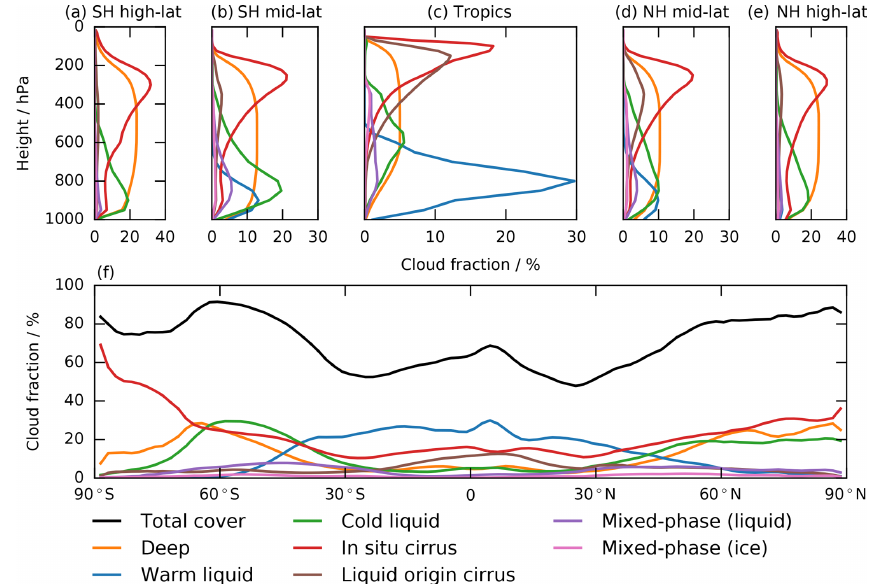
Figure 12. Same as in Fig. 5 but for the absolute frequency of occurrence profile (a–e) and relative contribution to the total cloud cover (f) . The relative contribution is computed as the fraction of cloud volume occupied per column and cloud type. Data are sampled every time step for 10 years of simulation with the new model